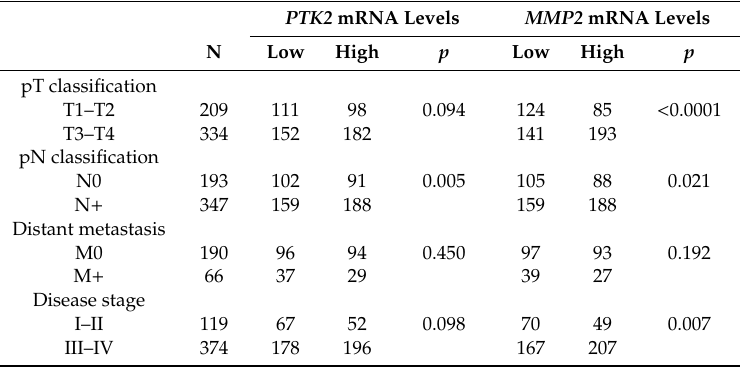
Table 1. Correlations between PTK2 and MMP2 mRNA levels and clinical variables of the patients with head and neck squamous cell carcinomas included in the TCGA